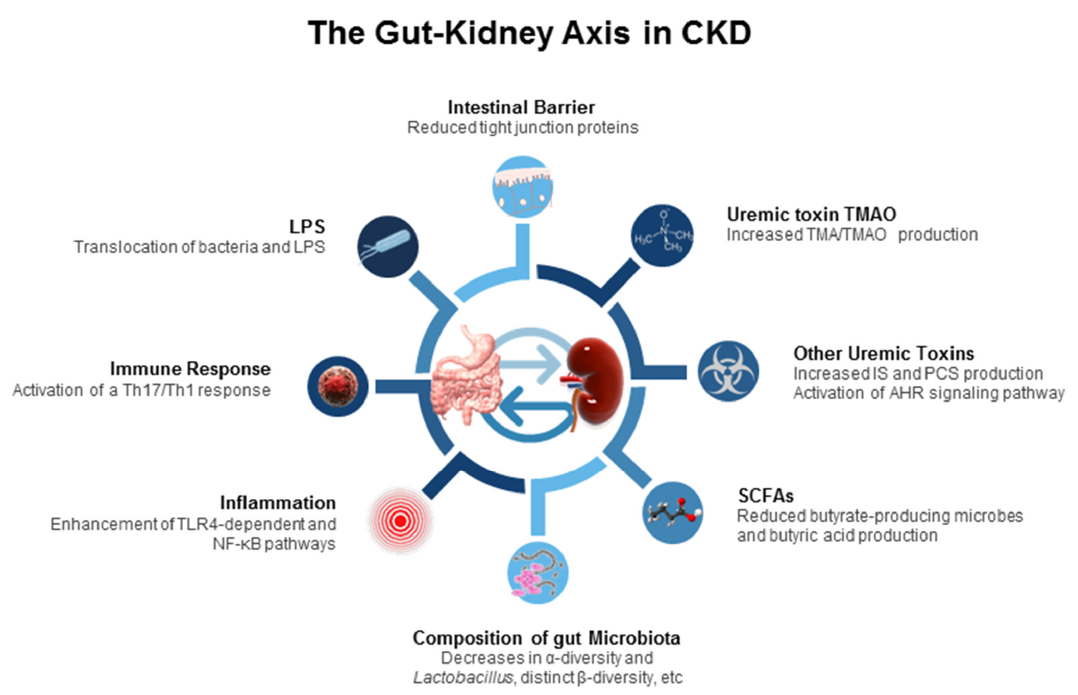
Figure 1. Schematic diagram summarizing the proposed mechanisms related to the gut–kidney axis involved in the pathogenesis of chronic kidney disease and its comorbidities. LPS = lipopolysaccharide; Th17 = T-helper 17 cell; Th1 = T-helper 1 cell; TLR4 = toll-like receptor 4; NF- κ B = nuclear factor kappa B; SCFA = short-chain fatty acid; IS = indoxyl sulfate; PCS = p-cresyl sulfate; AHR = aryl hydrocarbon receptor; TMA = trimethylamine; TMAO = trimethylamine-N-oxide. First, CKD can impair the intestinal barrier by disrupting the epithelial tight junction in a 5/6 nephrectomy rat model [64]. An apparent reduction of the tight junction proteins